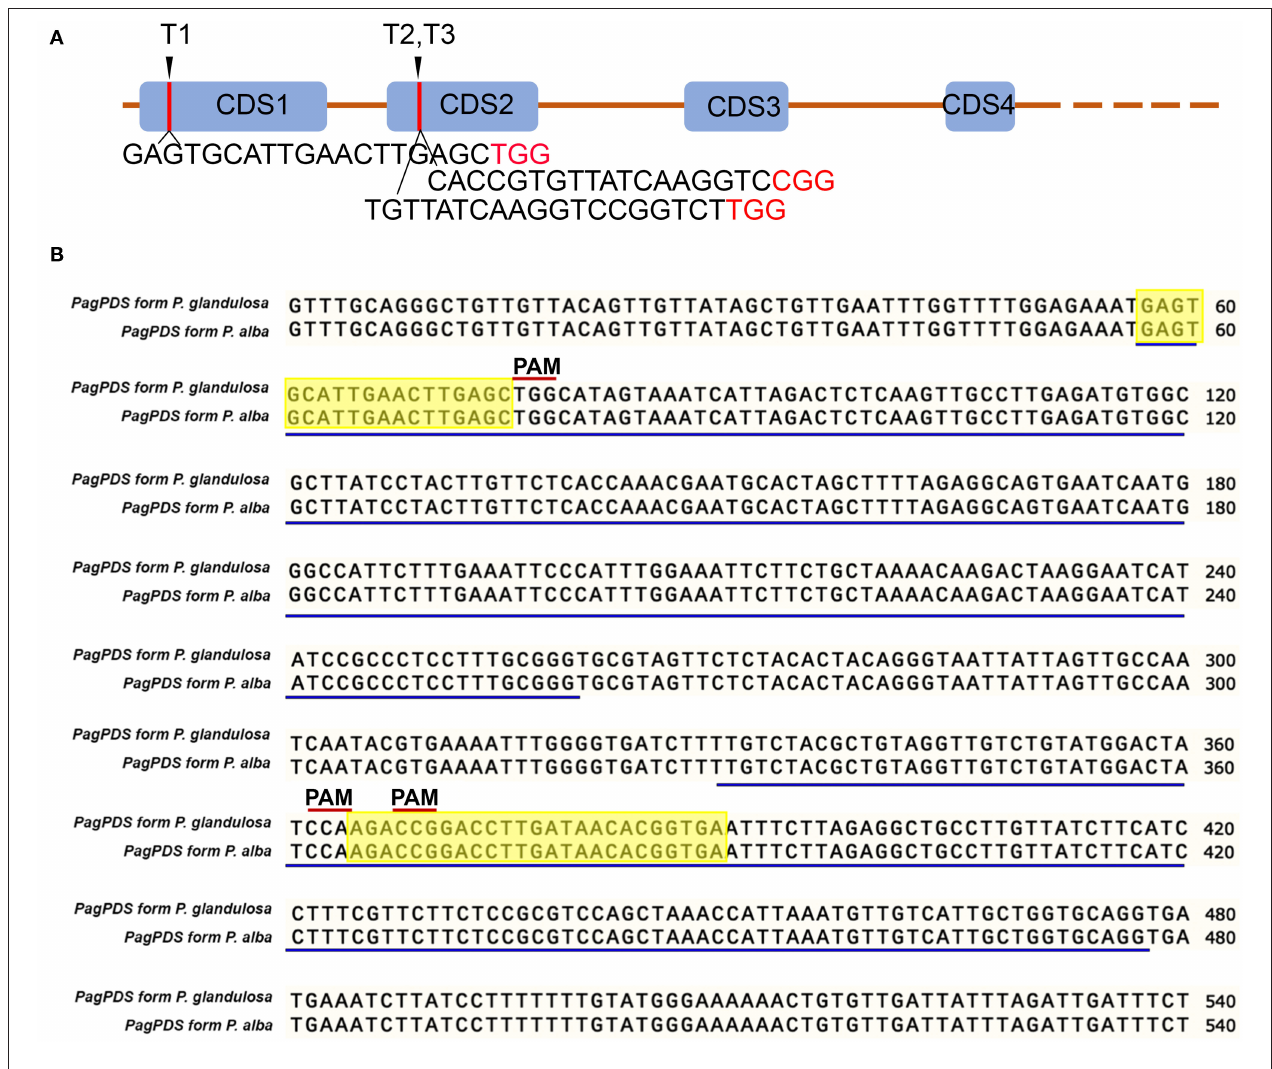
FIGURE 1 | Schematic diagrams illustrating the PagPDS target sites and PagPDS gene sequence alignment. (A) Schematic diagrams illustrating the PagPDS target sites (T1–T3) and their sequences. The PAM (5 ′ -NGG-3 ′ ) are denoted in red. Blue boxes indicate exons (exon1–exon4). Orange lines indicate introns. (B) PagPDS genomic sequences (exon1–exon2) from 84K ( Populus alba × P. glandulosa ). Blue lines indicate exons, letters in red indicate PAM sequence, highlighted indicate the 3 target